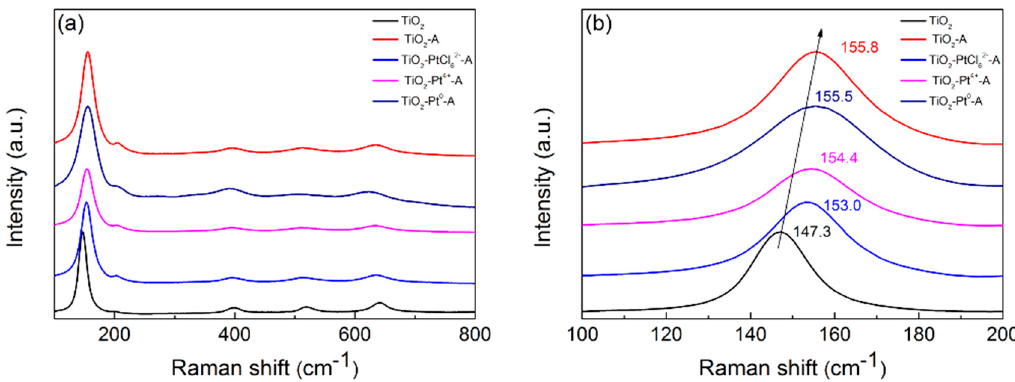
Figure 6. ( a ) Full Raman spectra; ( b ) locally magnified Raman spectra (100–200 cm -1 ) of the used Pt/TiO 2 and TiO 2 samples via three different Pt sources.